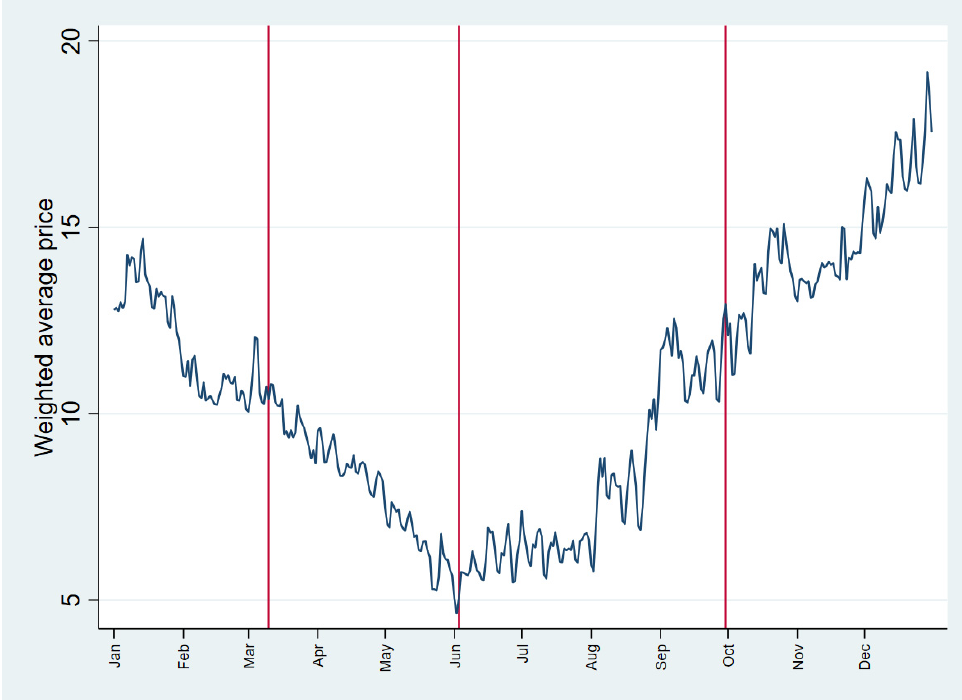
Figure 9. Daily Gas Weighted Average Price in the Italian Gas Market, 2020. Note: The weighted price is expressed in terms of euro/MWh. Source: Italian Day-Ahead Gas Market.